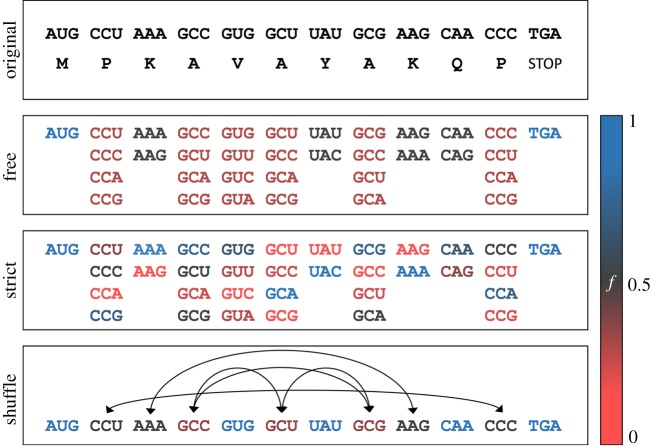
PACKEIS uses different models to generate artificial ORFs based on the oORF. Colours refer to the probability of a specific codon being placed at a given position. When applying model0 (free), PACKEIS uses equal probabilities for all codons of a specific amino acid. When applying model1 (strict), the probabilities are derived from the global codon usage of the species in question. When applying model2 (shuffle), codons of the oORF are randomly shuffled. Note that, in the above example, valine can only be encoded by GUG when applying model2 since no alternative valine codons are present in the given ORF.